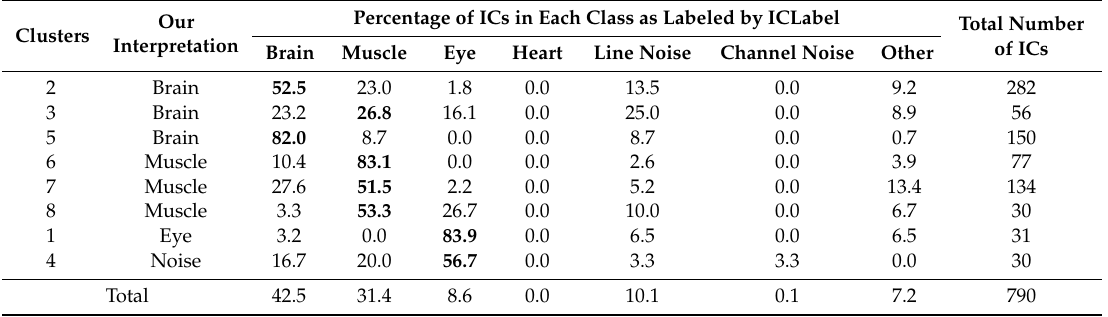
Table 1. Percentage of independent components (ICs) in each class (as labeled by ICLabel to the total number of ICs in each cluster; note that the clusters were reordered to enhance readability. Percentage of ICs in Each Class as Labeled by ICLabel Total Number Our Clusters Interpretation